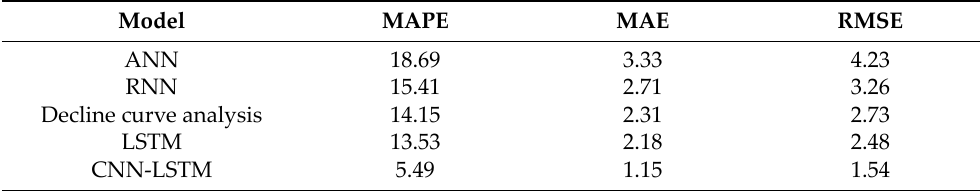
Table 2. Performance comparison for the five models.